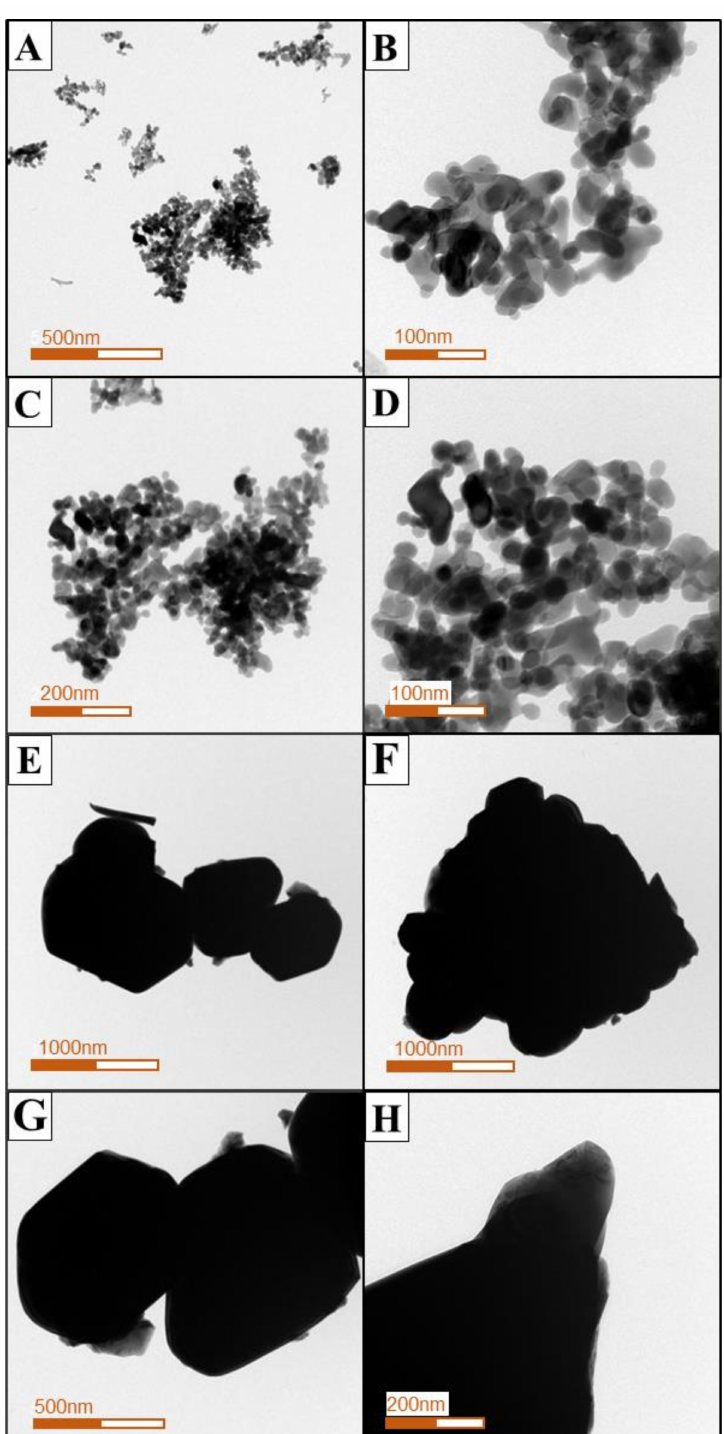
Figure 2. Transmission electron microscopy (TEM) images of the two di ff erent sizes of Co 3 O 4 nanoparticles. ( A – D ) for type A Co-NPs; ( E – H ) for type B